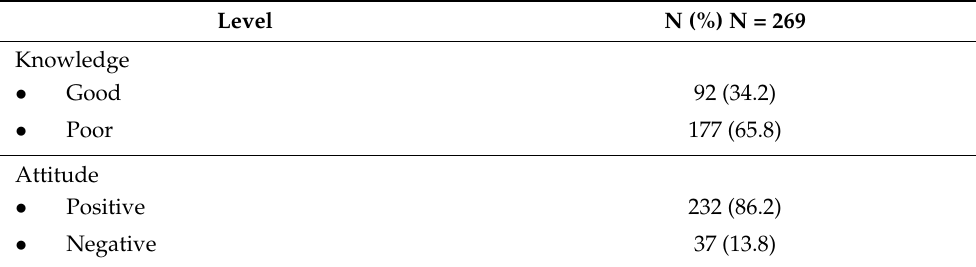
Table 2. Overall parental level of knowledge and attitudes.